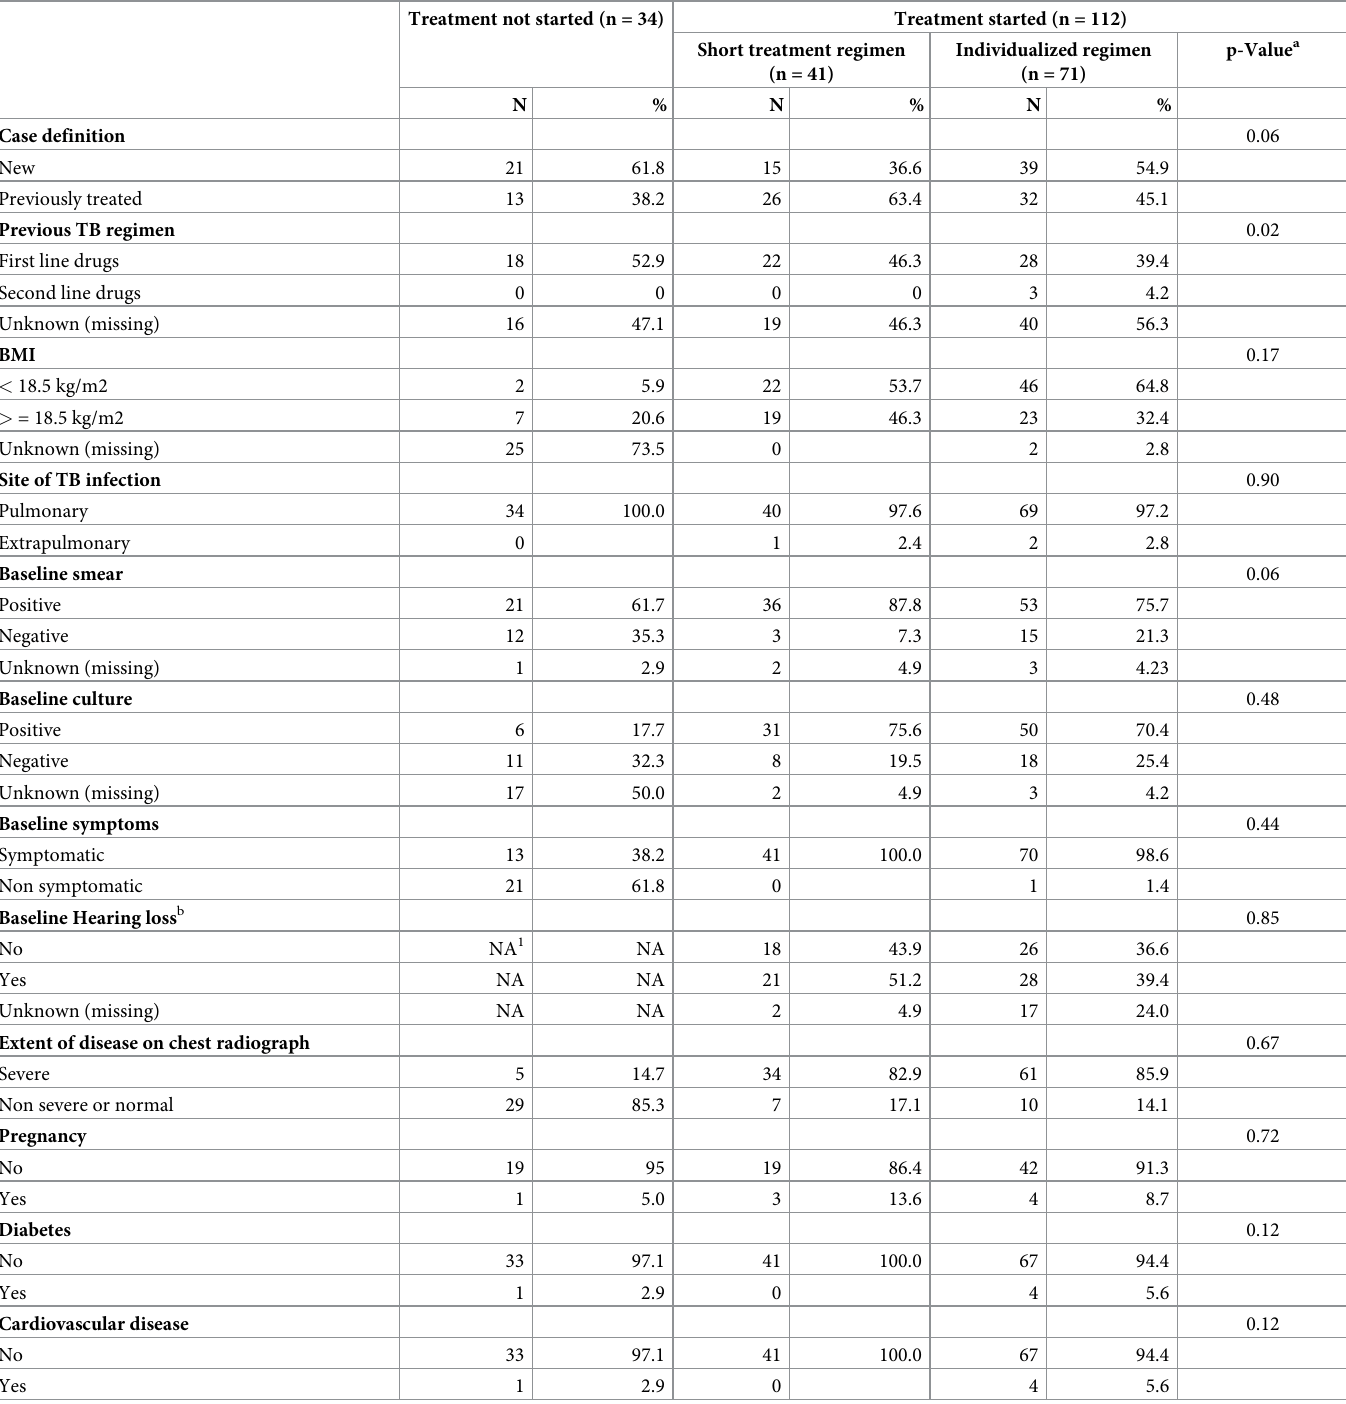
Table 2. Disease characteristic among patients who started RR-TB